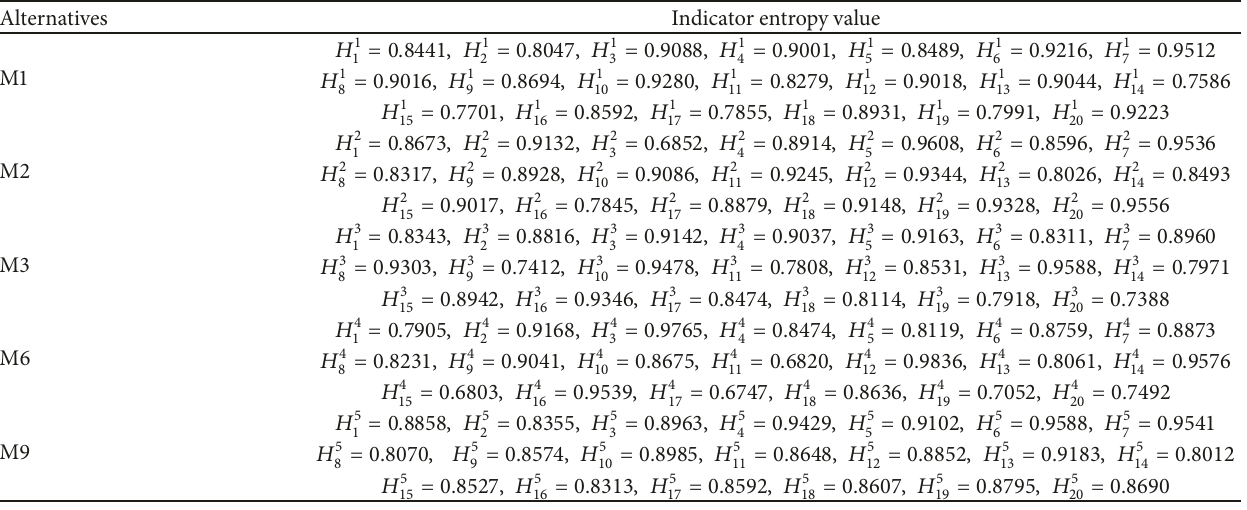
Table 2: The entropies of the 20 attributes for the five